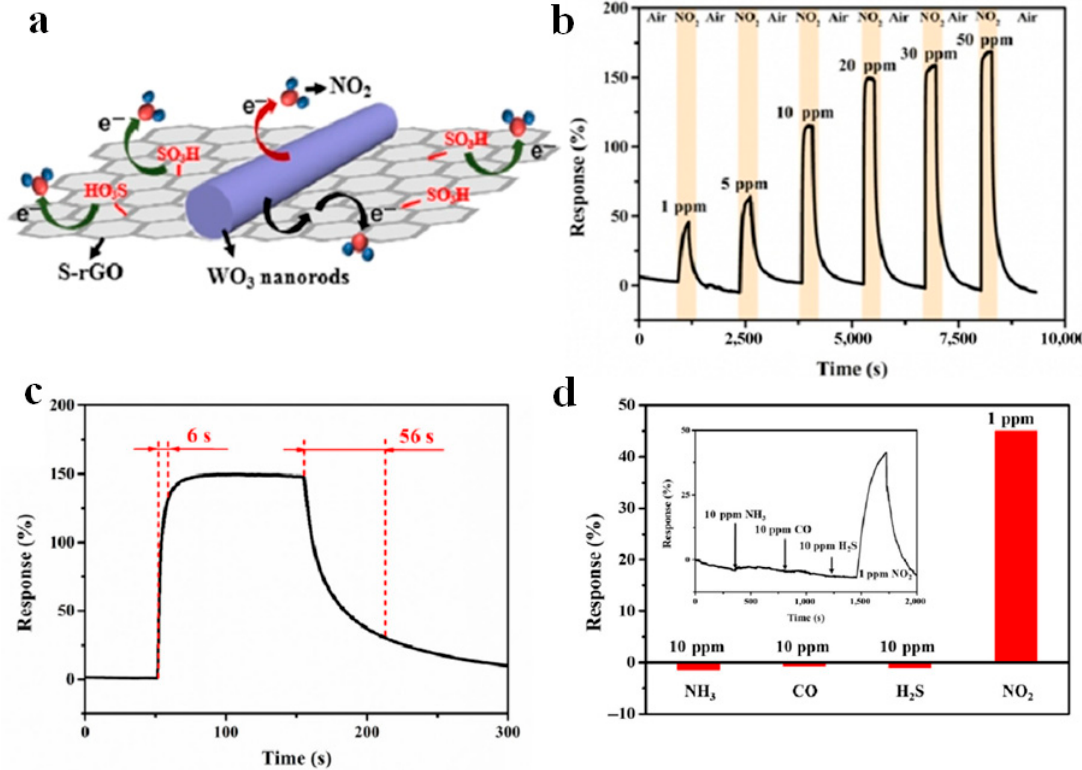
Figure 12. ( a ) Schematic illustration of NO 2 adsorption on S-rGO/WO 3 surface; ( b , c ) Dynamic response of the 3D S-rGO/WO 3 hybrids of NO 2 at room temperature.; ( d ) Selectivity of 3D S-rGO/WO 3 . Reproduced with permission from [106] © 2018 Springer.